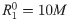
Performance of EM algorithm versus ODE integration.The steady state of the MicroCRM was computed by direct ODE integration and with our new EM algorithm for a range of values of the number of resource types M. The initial number of species S was set equal to M, and a single resource type was externally supplied with intrinsic fixed point R10=10M (Ri0=0 for all i > 1). The absolute error tolerance of the integrator was set to 10−4, and the convergence tolerance for the EM algorithm was set to δ = 10−7. See ‘scripts’ folder in the ‘EM-algorithm’ branch of the GitHub repository for the rest of the parameters, which were held fixed for all simulations. (a) Total computation time for 10 realizations. (b) Final root-mean-square per-capita deviation of the growth rate from zero (‘Error’) over all surviving species in all 10 samples.